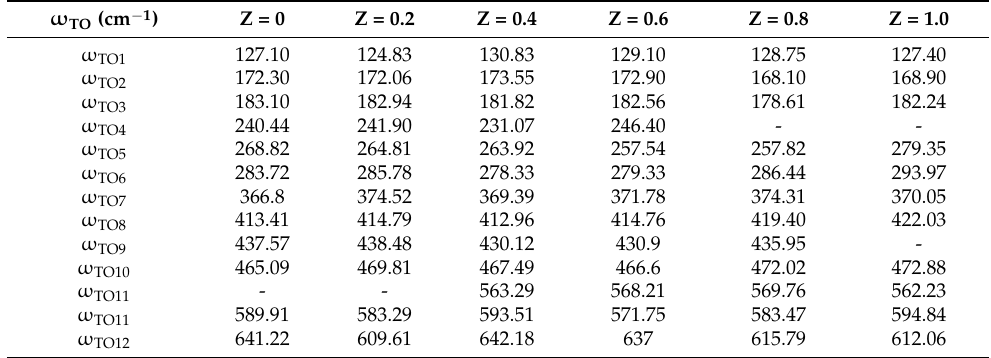
Figure 4. The imaginary parts of ( left side) the dielectric function of the La 2 Co 1 − z Fe z MnO 6 (z = 0, 0.2–1.0) ceramics at room temperature in the far-infrared regions and ( right side) the reciprocal dielectric function. Table 2. Fitted parameters of optical transverse phonons of ( ω TO ) at room temperature.